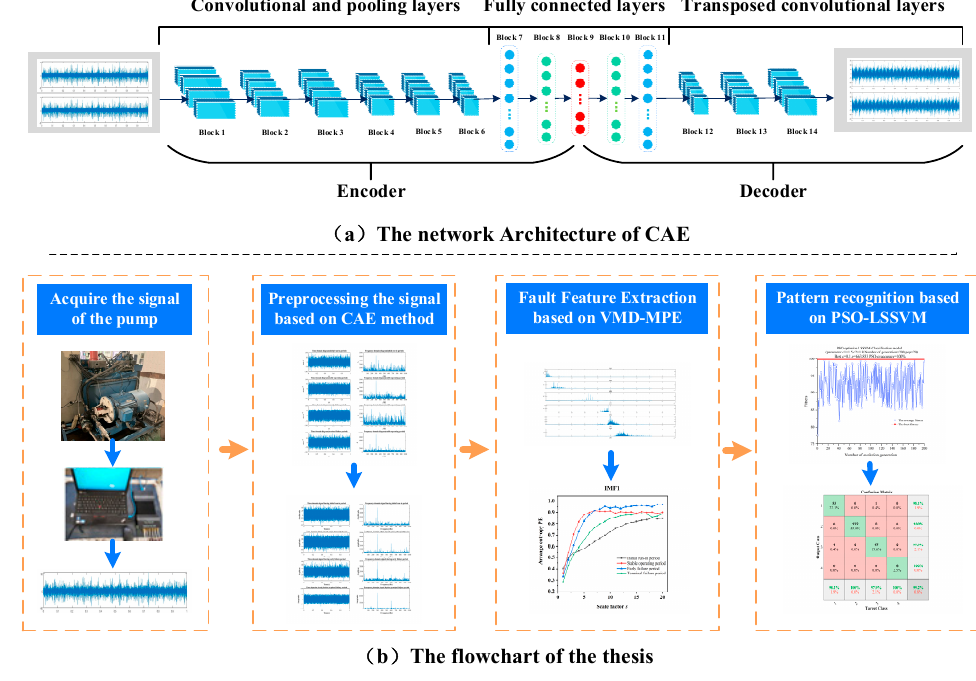
Figure 3. CAE architecture and flow chart. Table 1. Detailed configuration parameters of CAE.